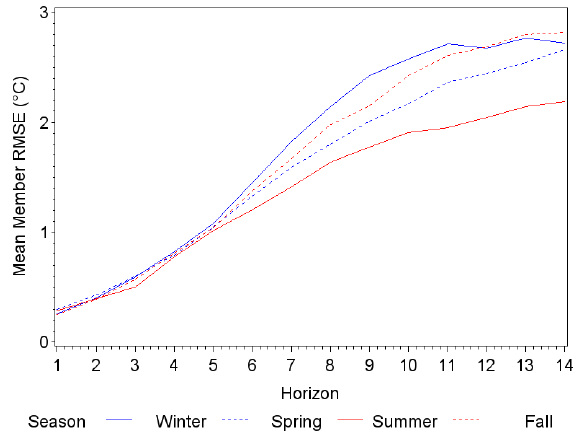
Fig. 3. Mean forecast error, using ensemble prediction system mean